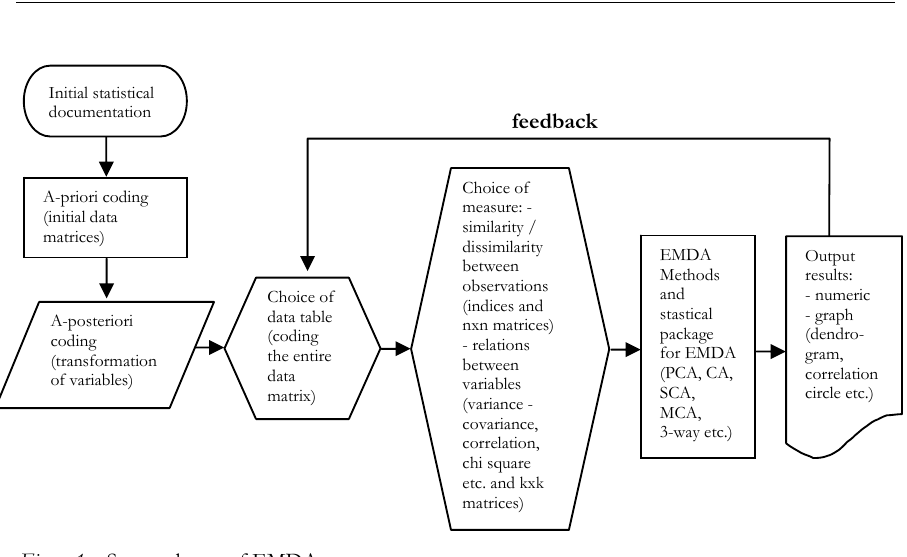
Figure 1 – Seven phases of